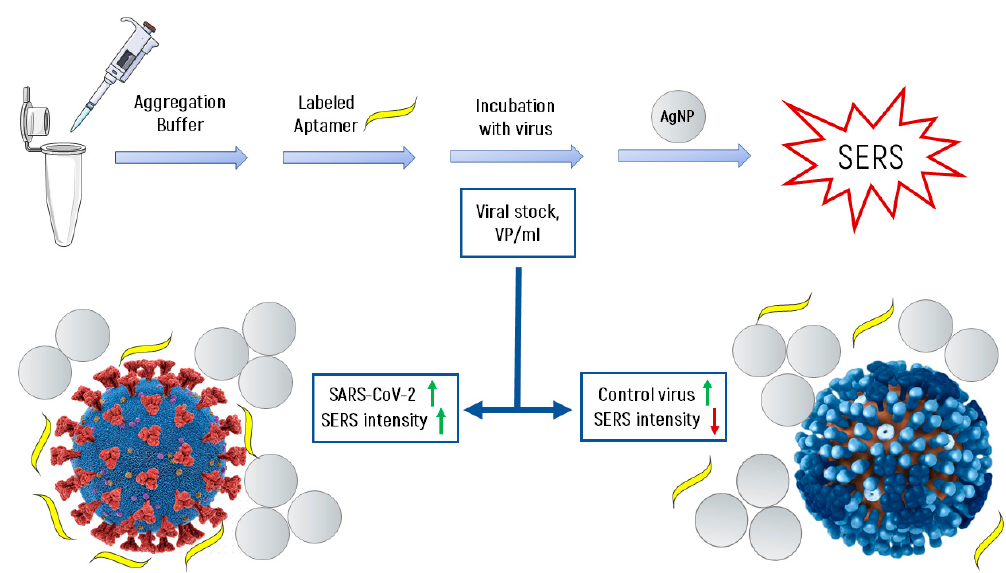
Figure 5. The scheme of the experiment and the formation of the SERS signal.